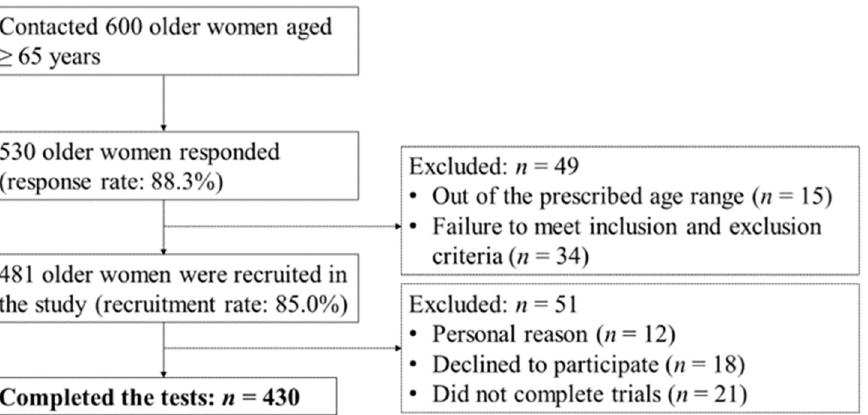
Figure 1. Flow diagram of the participant recruitment process.